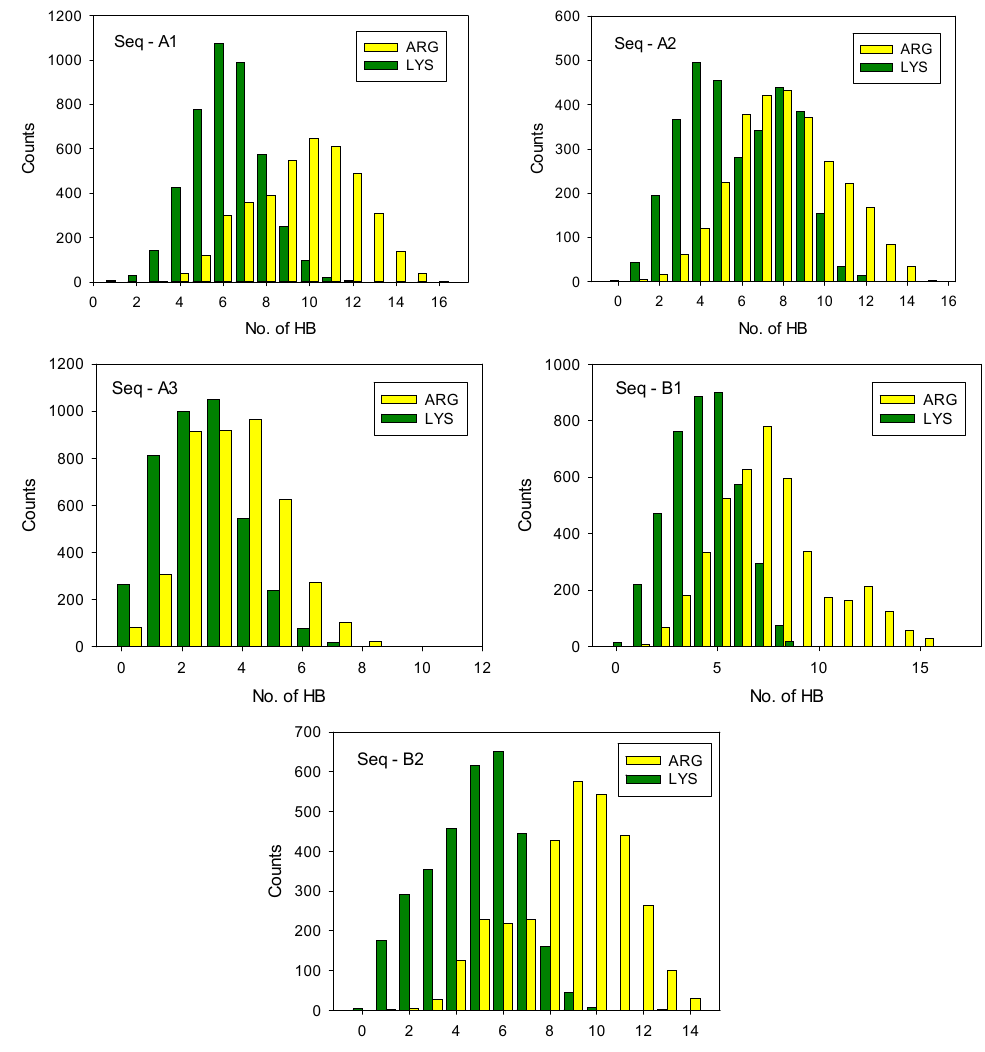
Figure 8. Histograms of the number of hydrogen bonds during molecular dynamic simulation of polypeptide-casein fragment complexes, calculated with 10 replica of the random initial position of casein fragments and PLArg / PLL oligomers. HB sampling time 5 ns, sampling frequency 0.01